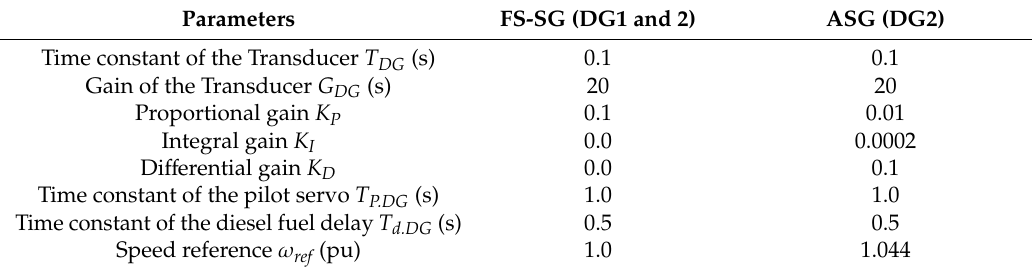
Figure 2. Speed governor and torque output model of a diesel engine. Table 2. Parameters of the diesel governors.